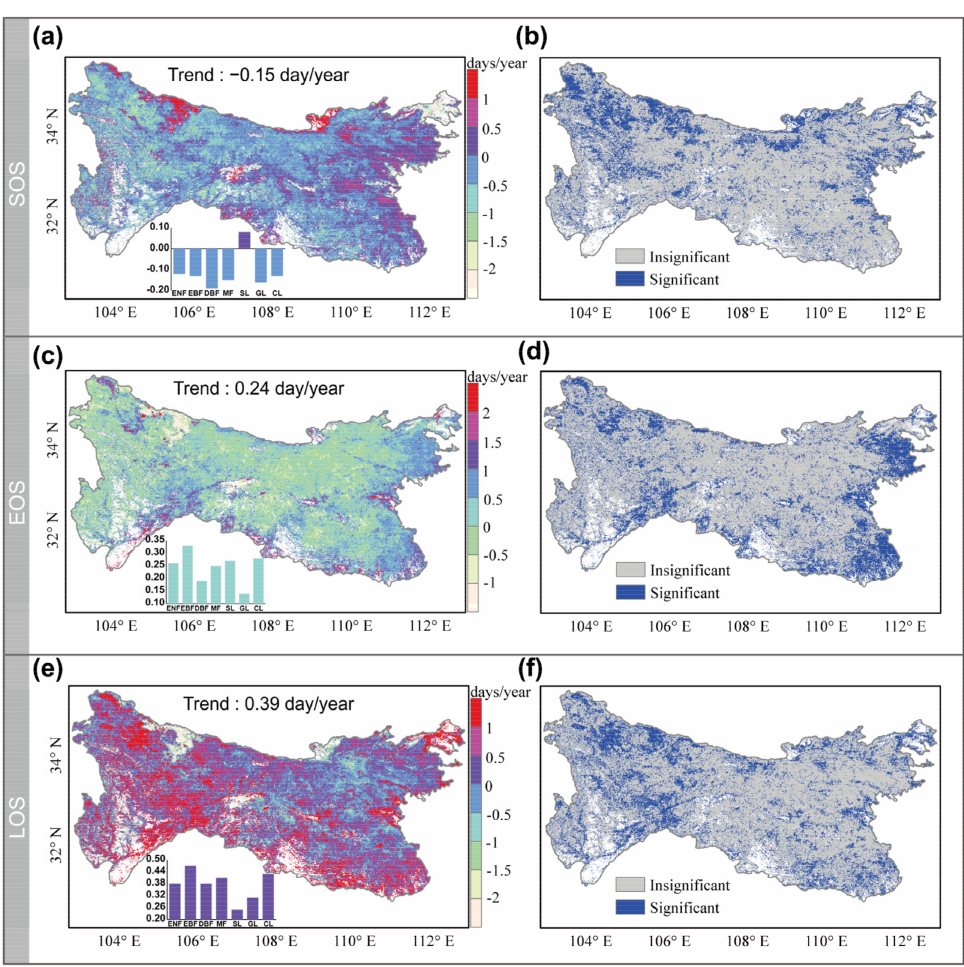
Figure 5. ( a , c , e ) Spatial distribution of phenology metrics trends from 2001 to 2019 and ( b , d , f ) significant ( p < 0.1) changes in phenology metrics trends for the study periods. Insets at bottom left show the average pixel values of the trends of the phenology metrics for the different vegetation types. Data of interannual variation trends and the significance of LSP for different vegetation types are shown in Figure 6. Overall, the Sen’s slope of SOS is − 0.09 days/year from 2001 to 2019, but this advance is insignificant. There was a trend of significant SOS advancement for DBF and GL, at 0.16 and 0.13 days/year, respectively. EOS shows a significant delay trend over the entire region of 0.29 days/year. The trend of EOS delay was more significant for both EBF and CL compared to other vegetation ( p < 0.05), and the rate of EBF delay was the fastest (0.37 days/year). LOS is significantly lengthened at a rate of 0.48 days/year. ENF, EBF, DBF, MF, and CL show a more significant trend for lengthened LOS ( p < 0.05), with the fastest being for EBF (0.68